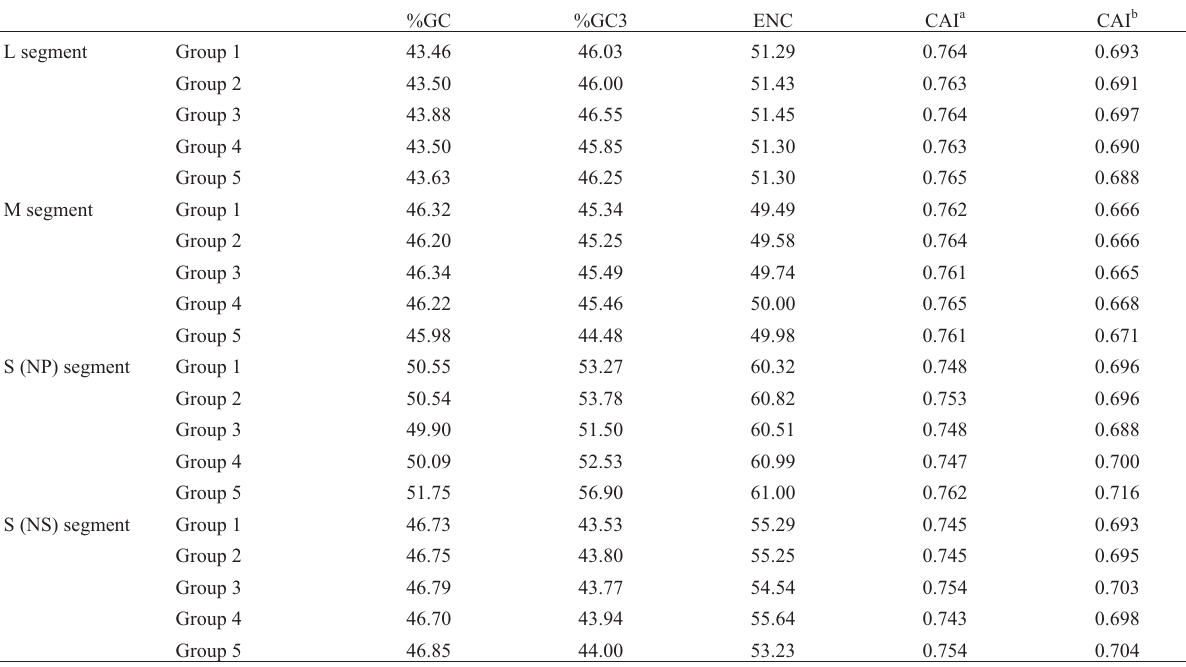
Table 3 - %GC, %GC3, ENA and CAI values of RVFV